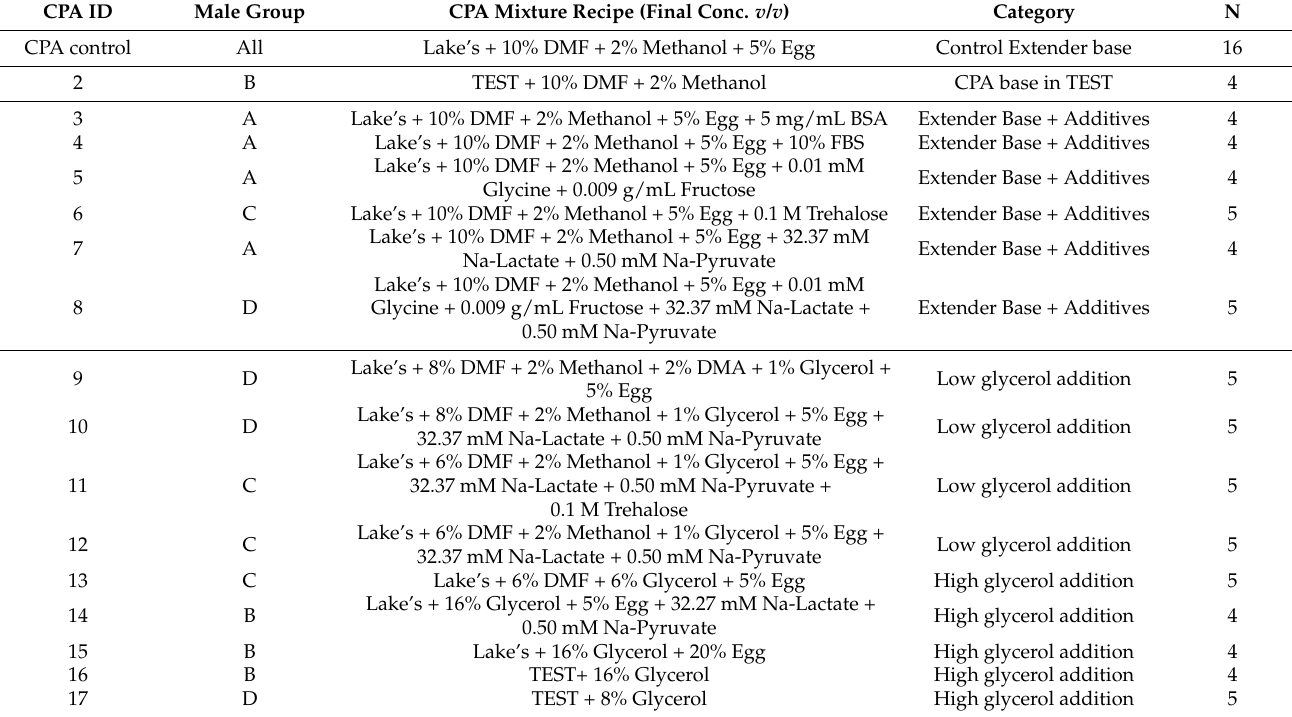
Table 1. Summary table of the 17 CPA treatment mixtures used to test the cryosurvival of sperm collected from the Louisiana pinesnake, P. ruthveni . Treatment recipes were reported as final concen- trations following a 1:1 dilution ( v / v ) with semen. The groups were randomized groupings of males used to test a set of CPA treatment mixtures. Category refers to the three categories of experimental tests: CPA base in TEST, Extender base plus additives, and glycerol tests (high vs.